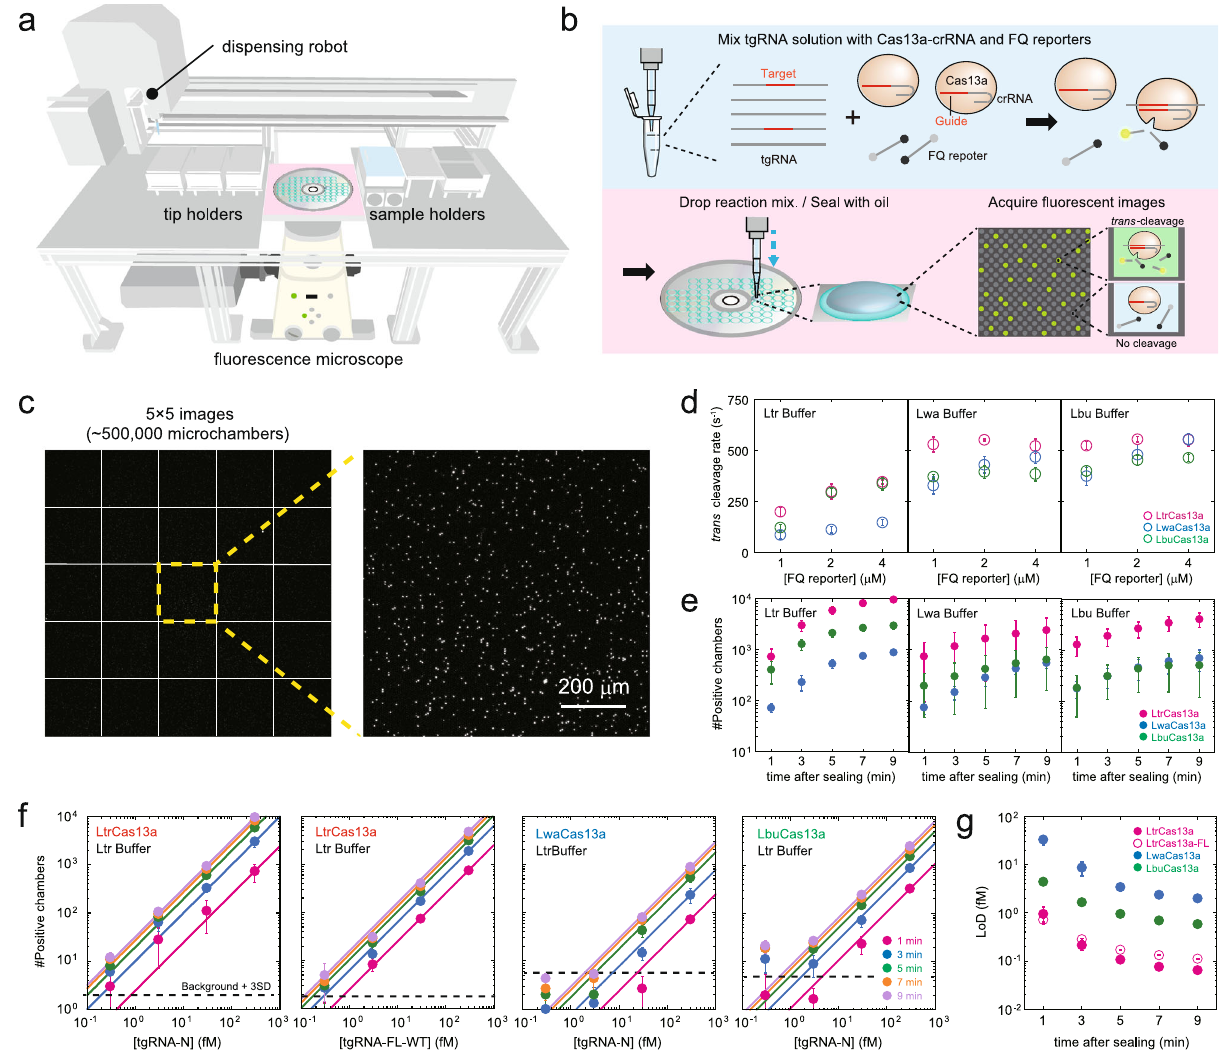
Fig. 1 Automated platform for ampli fi cation-free digital RNA detection with a CRISPR-Cas13a and CD-based microchamber device. a Schematic illustration of the automated platform consisting of a fl uorescence microscope and a custom-made dispensing robot. b Assay procedures. Upon tgRNA binding, the Cas13a-crRNA complex cleaves FQ reporters, resulting in increased fl uorescence in the microchamber. c Representative fl uorescence images obtained with 300 fM tgRNA. Using tiling-based imaging, 25 fl uorescence images containing ~500,000 microchambers can be acquired in less than 2 min. Scale bar is 200 μ m. d Comparison of the trans -cleavage activities of the Cas13a orthologs at the single-molecule level using different concentrations of FQ reporters. e Comparison of the number of positive chambers obtained with the different Cas13a orthologs. The Ltr-N2/Lwa-N2/Lbu-N2 and the SARS- CoV-2 N-gene (300 fM) were used as the crRNA and tgRNA, respectively. f The number of positive chambers obtained with the different Cas13a orthologs at different concentrations of the N-gene or the whole genome RNA of SARS-CoV-2. The data were acquired at 1, 3, 5, 7, and 9 min after oil sealing. The solid lines indicate linear regressions. The values of the background mean + 3 S.D. are indicated by dotted lines. g Time courses of LoD values determined from ( f ) ( n = 3 technical replicates for d – g